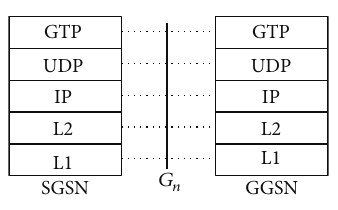
Figure 2: Typical signaling protocol stack at the Gn interface between SGSN and